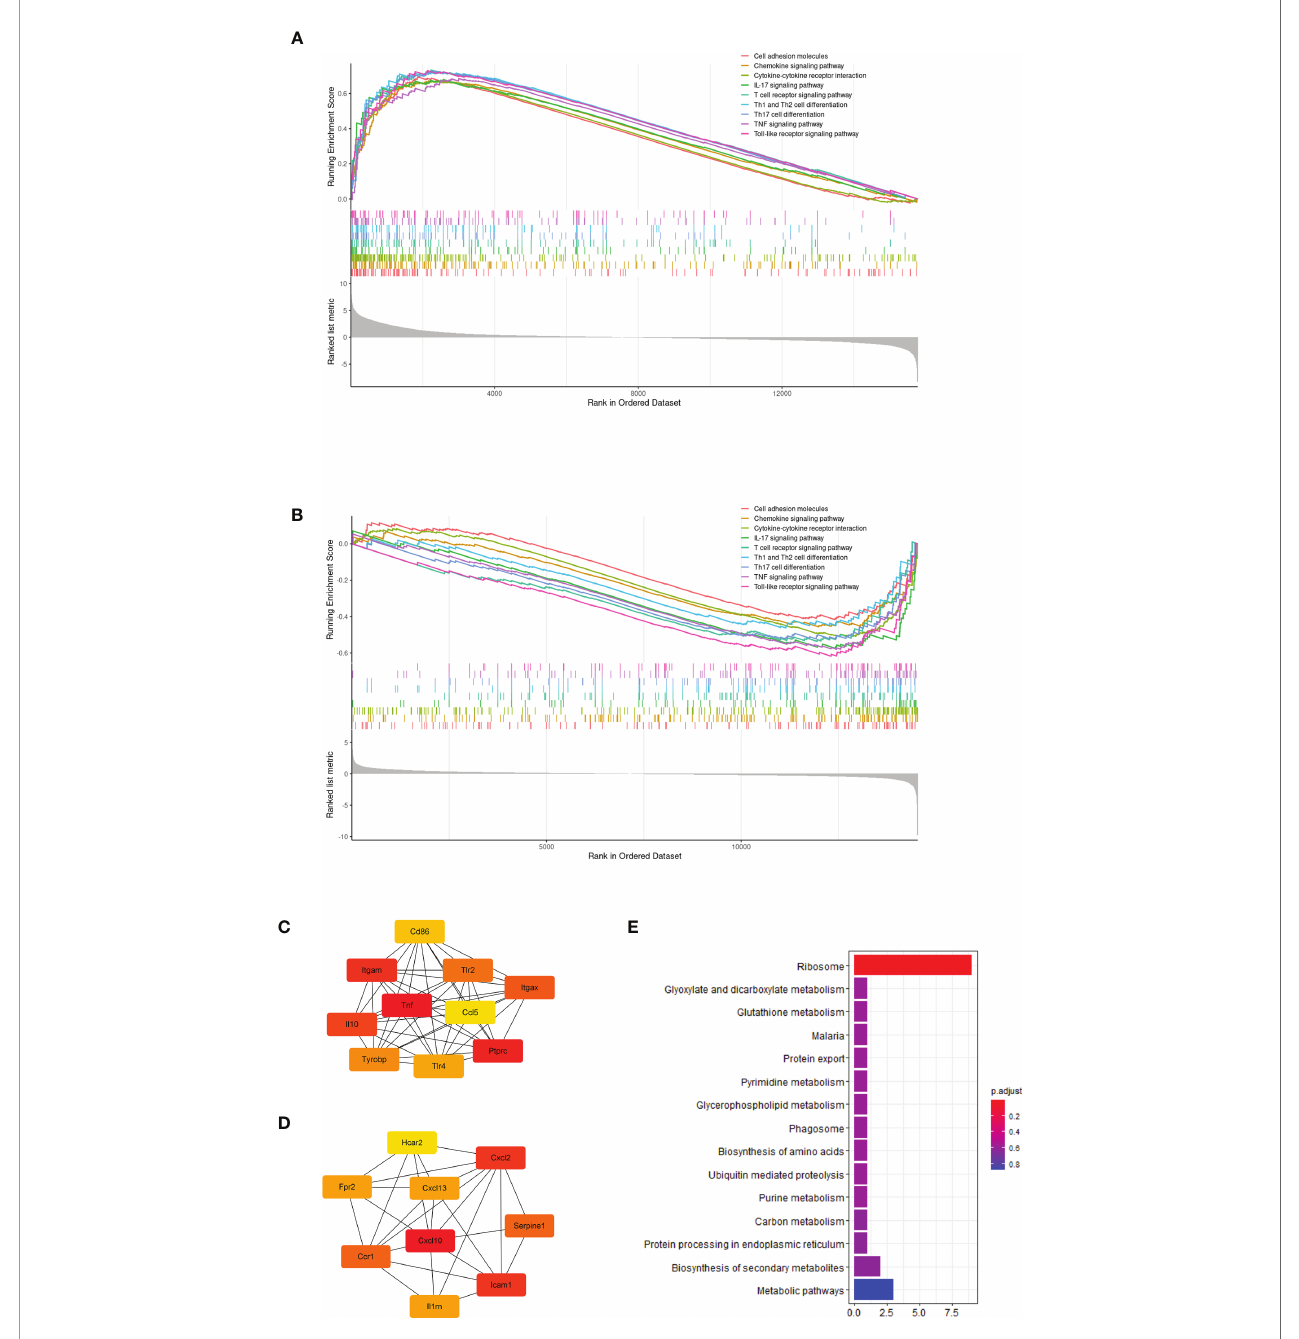
FIGURE 2 | Bioinformatics analysis based on transcriptome showed that G6pd-de fi cient mice altered the immune response in response to P.berghei infection. (A) GSEA showed that P.berghei infected wild type mice signi fi cantly upregulated the immune response compared to uninfected mice on day 7 post-infection. (B) GSEA showed that G6pd-de fi cient mice down-regulated immune response compared to wild type mice on day 7 post-infection. (C) PPI analysis based on signi fi cantly differentially expressed genes(uninfected wild mice compared to infected wild mice) showed that P.berghei infection induced host antigen recognition and immune response compared to uninfected mice on day 7 post-infection. The redder the color, the more critical the gene is in the network. (D) PPI analysis based on signi fi cantly differentially expressed genes(infected wild mice compared to infected hemizygous mice) showed that G6pd-de fi cient mice suppressed the immune response induced by P.berghei infection compared to wild type mice on day 7 post-infection. The redder the color, the more critical the gene is in the network. (E) KEGG enrichment of differentially expressed genes of Plasmodium parasites on different hosts. Unmapped reads were extracted and aligned to the P.berghei genome and differentially expressed genes were identi fi ed and enriched with KEGG database. The ribosome loss maybe occurs in P.berghe i parasites on the G6pd- de fi cient